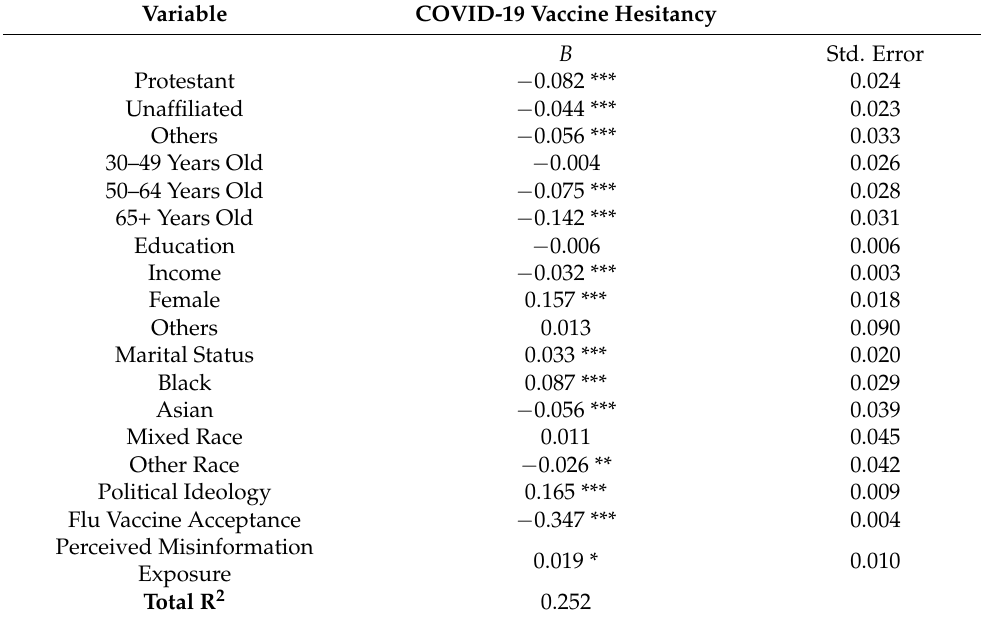
Table 1. Predicting COVID-19 vaccine